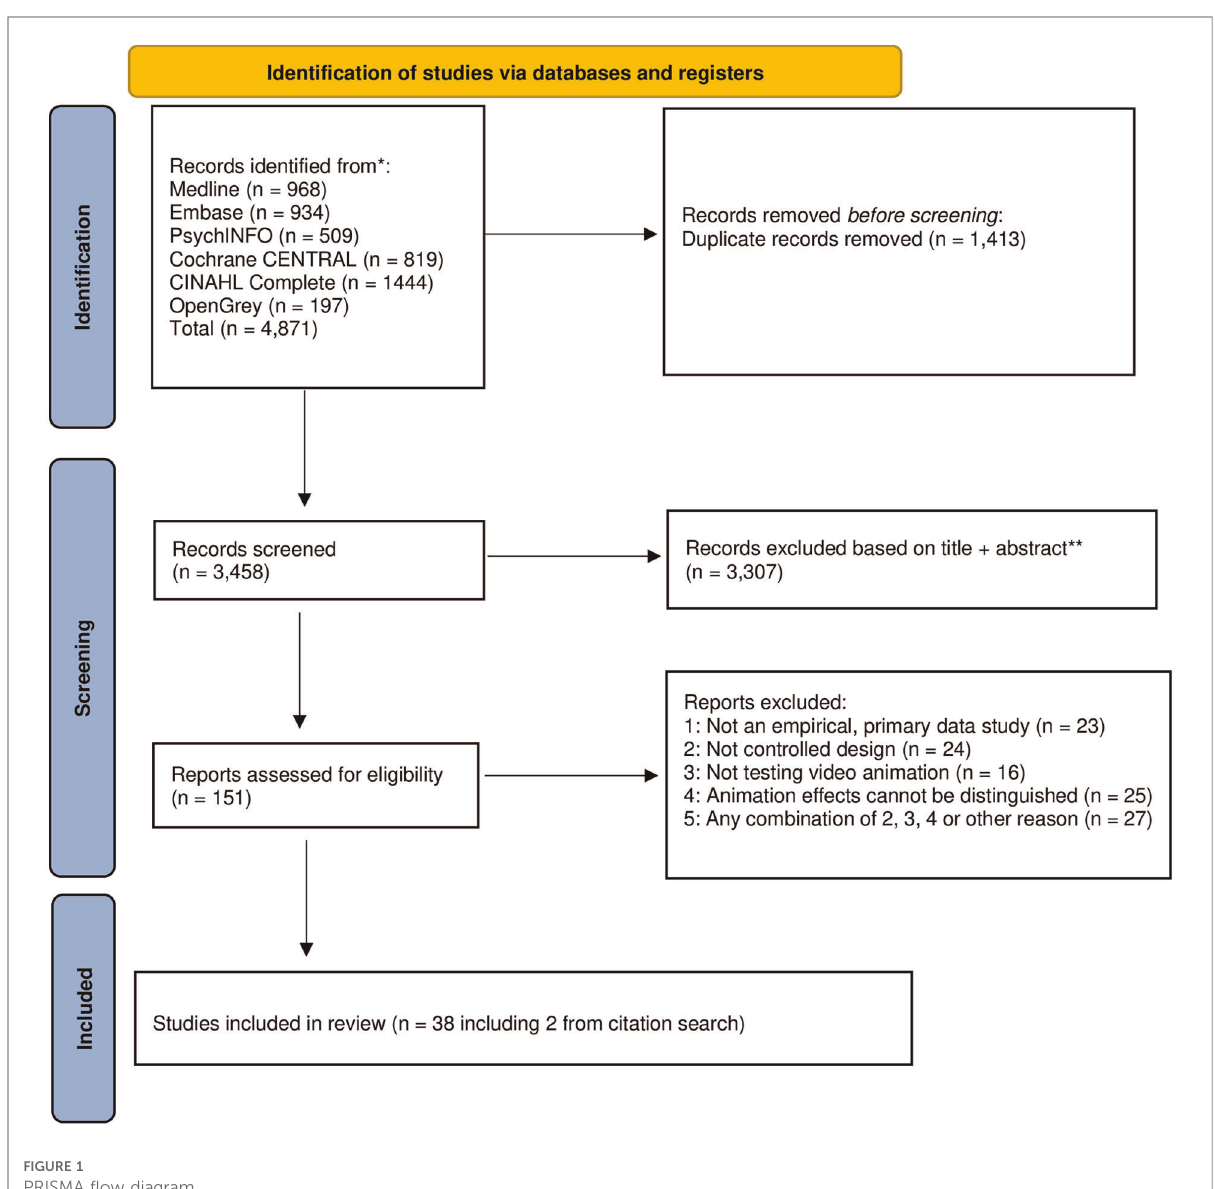
FIGURE 1 PRISMA fl ow